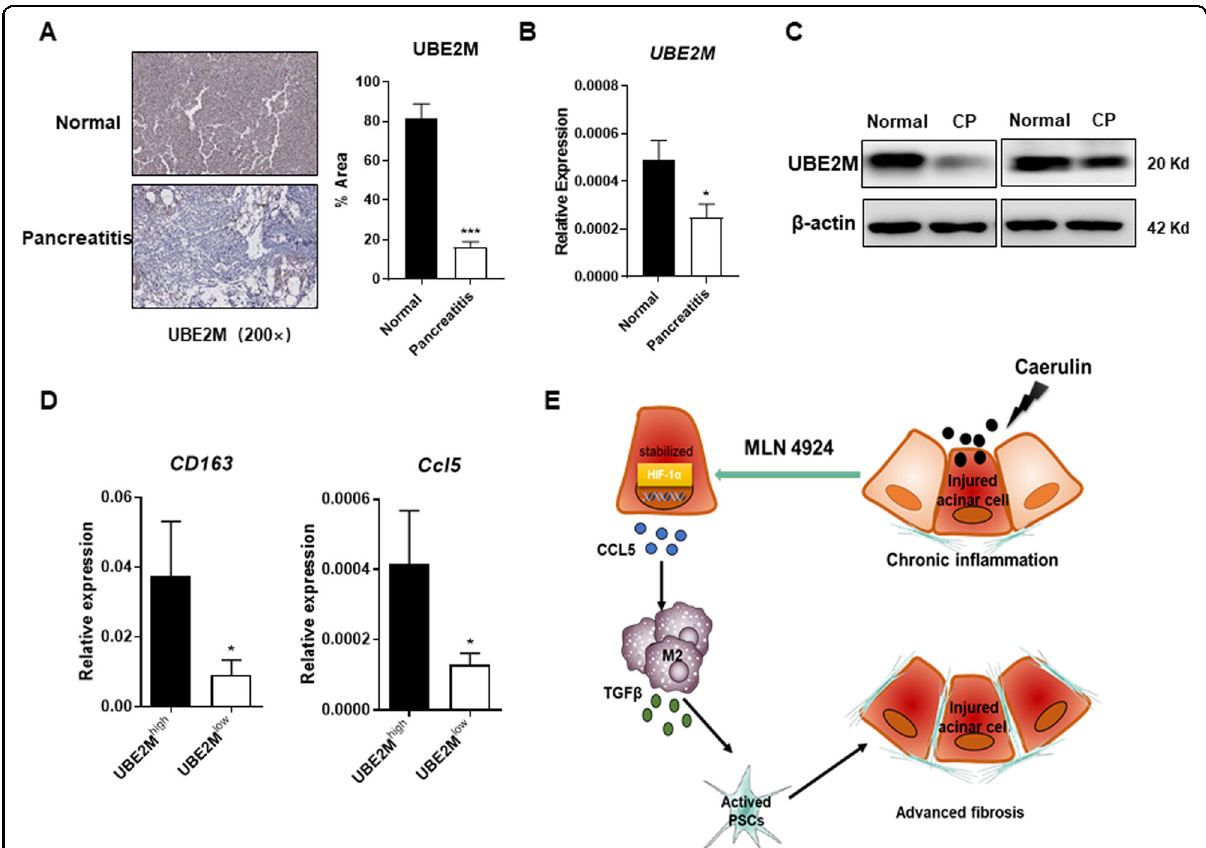
Fig. 6 Expression pro fi le in CP patients and working model. A Representative IHC images of UBE2M expression in CP specimens and normal tissues, and the bar graphs. B mRNA expression of UBE2M in CP specimens and normal tissues. C Western blot analysis of UBE2M in CP specimens and normal tissues. D mRNA expression of CCL5 and CD163 in UBE2M high and UBE2M low CP specimens. E A working model depicting that inactivation of neddylation pathway by MLN4924 stabilizes HIF-1 α level, upregulates CCL5 expression, accelerates macrophage in fi ltration, and eventually exacerbates chronic pancreatitis. A – D n = 3. Data are representative of three independent experiments. *p < 0.05, ** p < 0.01, *** p < 0.001, ns no signi fi